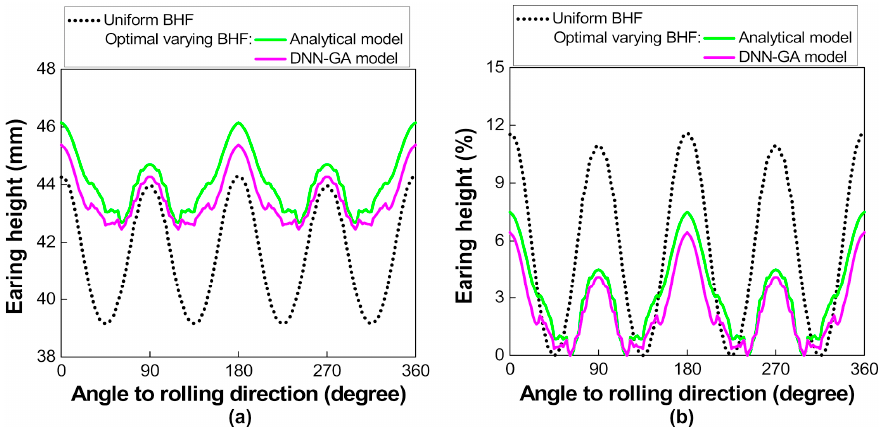
Figure 15. Comparison of ( a ) earing height and ( b ) % earing height profiles of AA1050-O predicted by the optimal varying BHFs using the analytical and DNN-GA models.